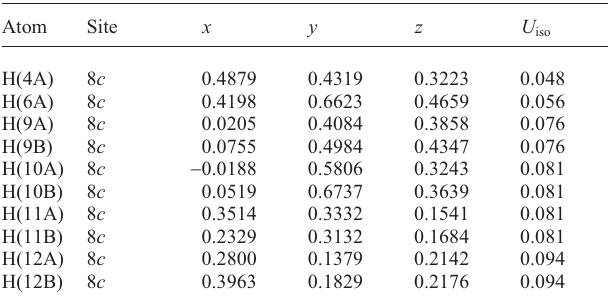
Table 1. Data collection and handling. Table 2. Atomic coordinates and displacement parameters (in Å 2 )